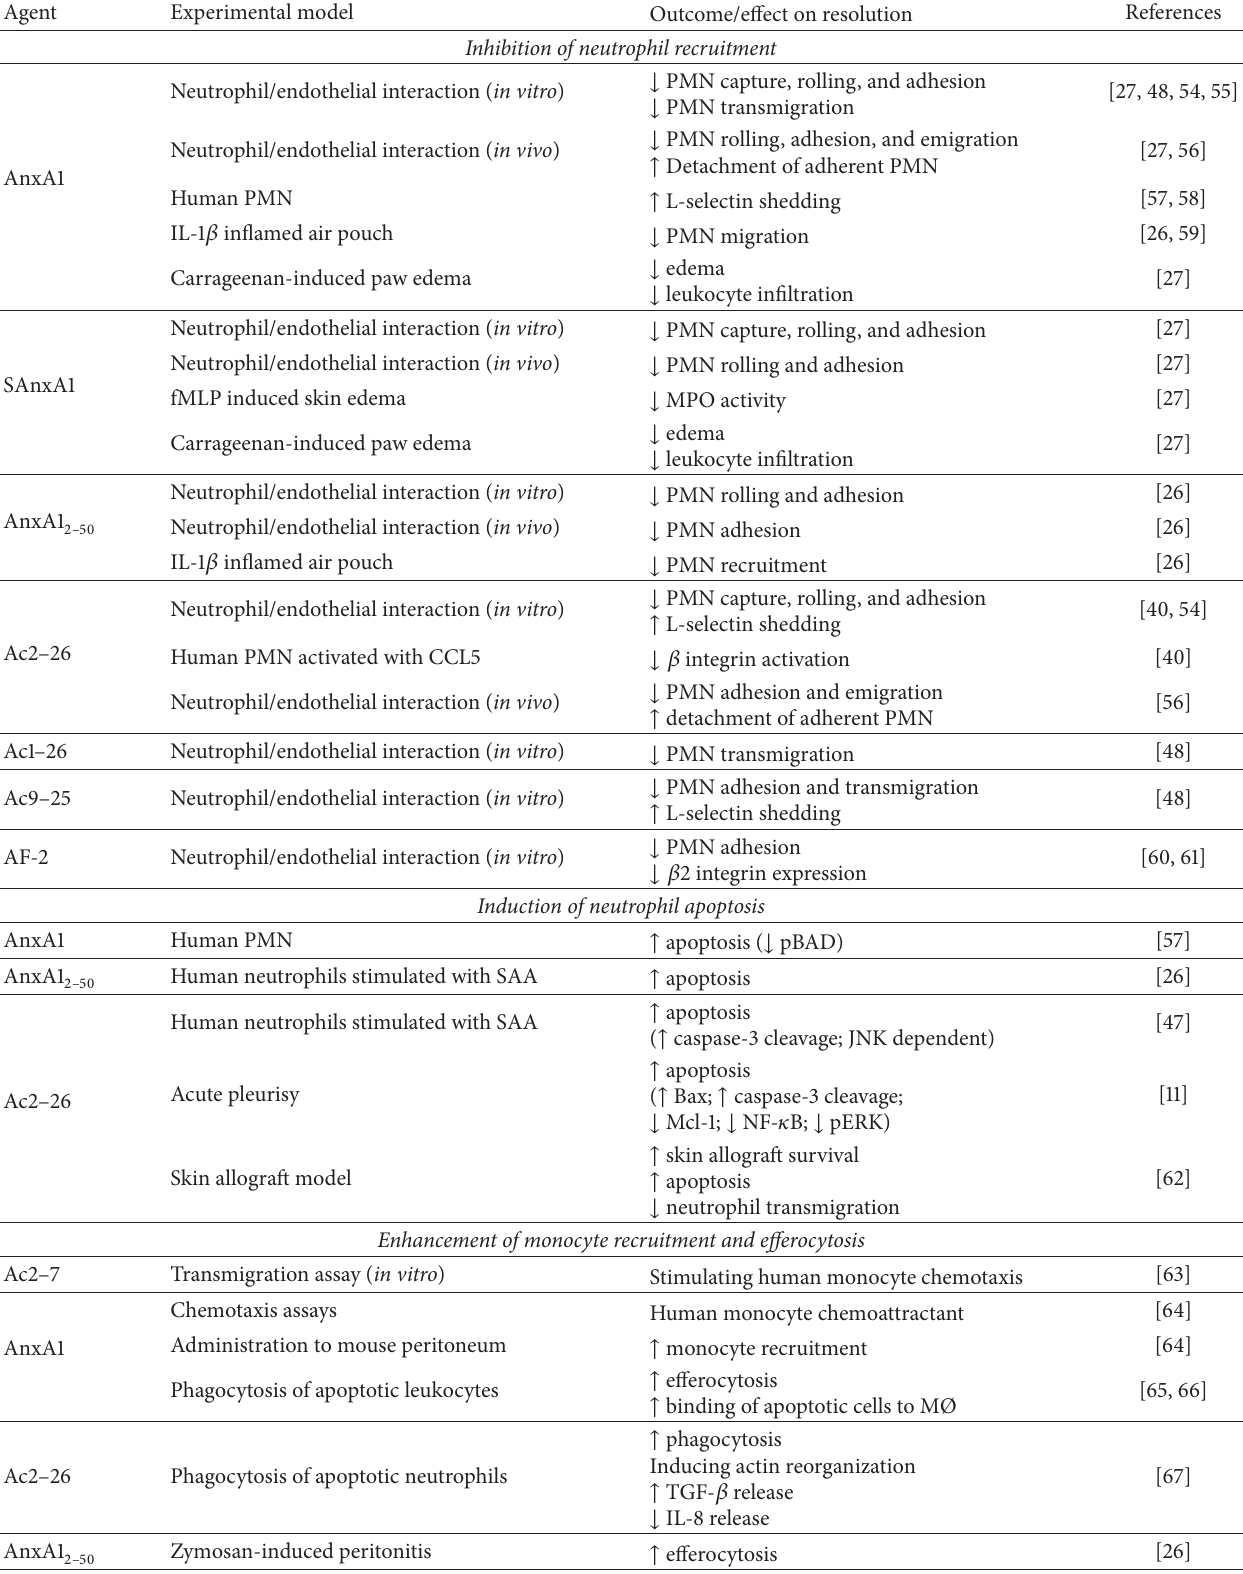
Table 1: In vitro and in vivo evidence for anti-inflammatory and proresolving properties of annexin A1 and its fragments.